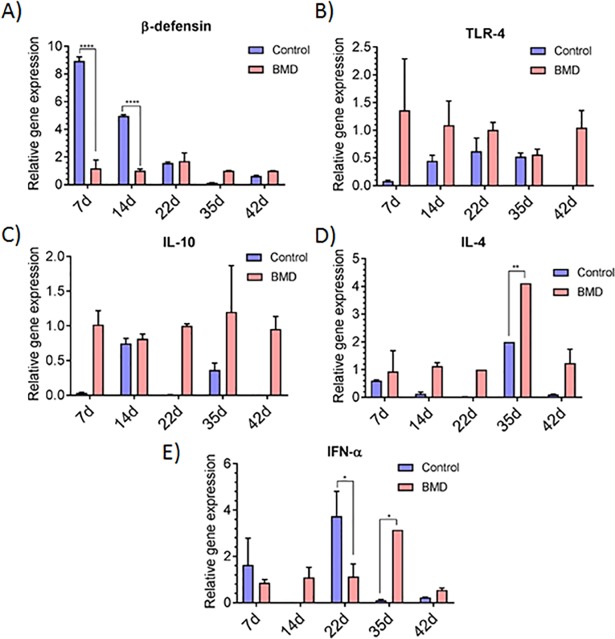
Change in cytokine gene expression (A) β-defensin (B) TLR-4 (C) IL-10 (D) IL-4 and (E) IFN-α in the ilea. Values are represented as means ± standard error of mean, where n = 4.